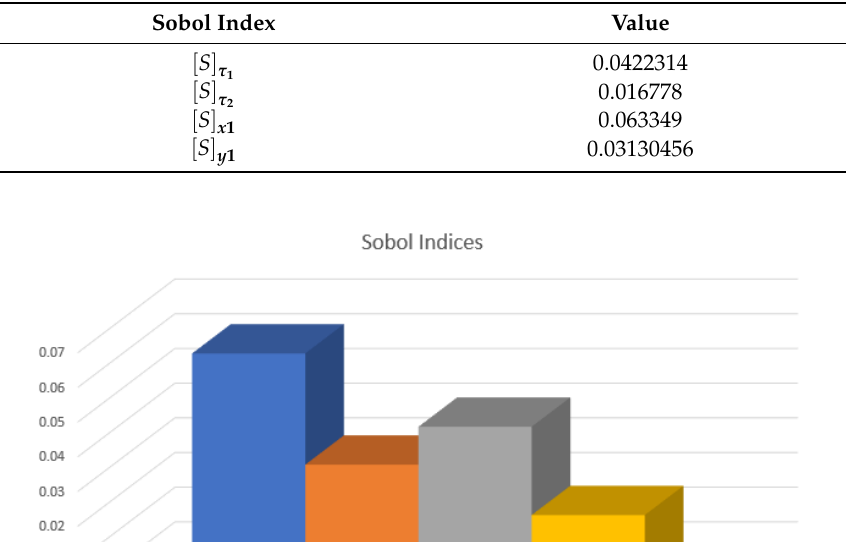
Table 6. First-order sensitivity index (or Sobol Index) value for each parameter.